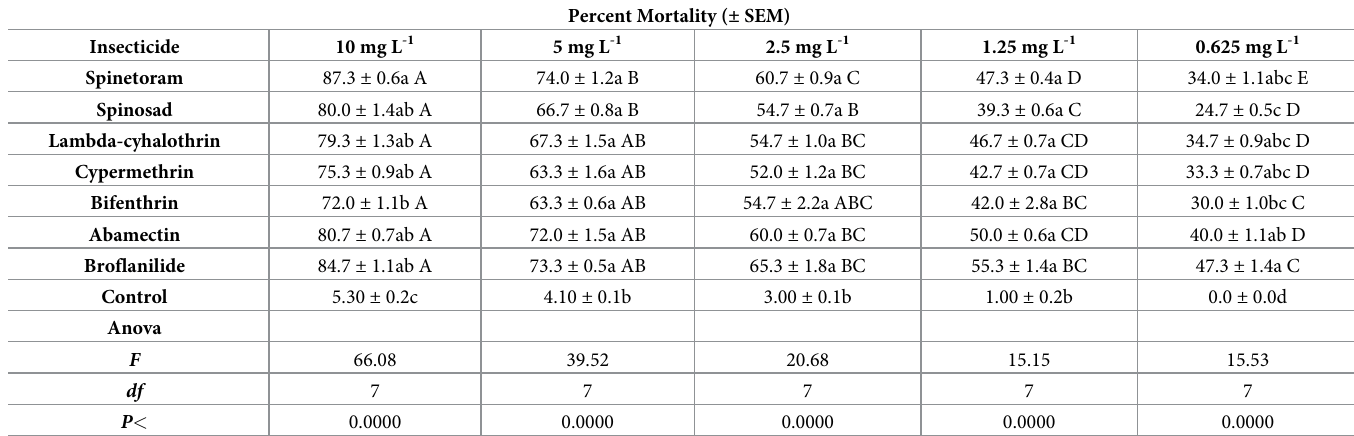
Table 3. Percent cumulative mortality of second instar S . frugiperda larvae to synthetic insecticides at 48 h post-treatment.